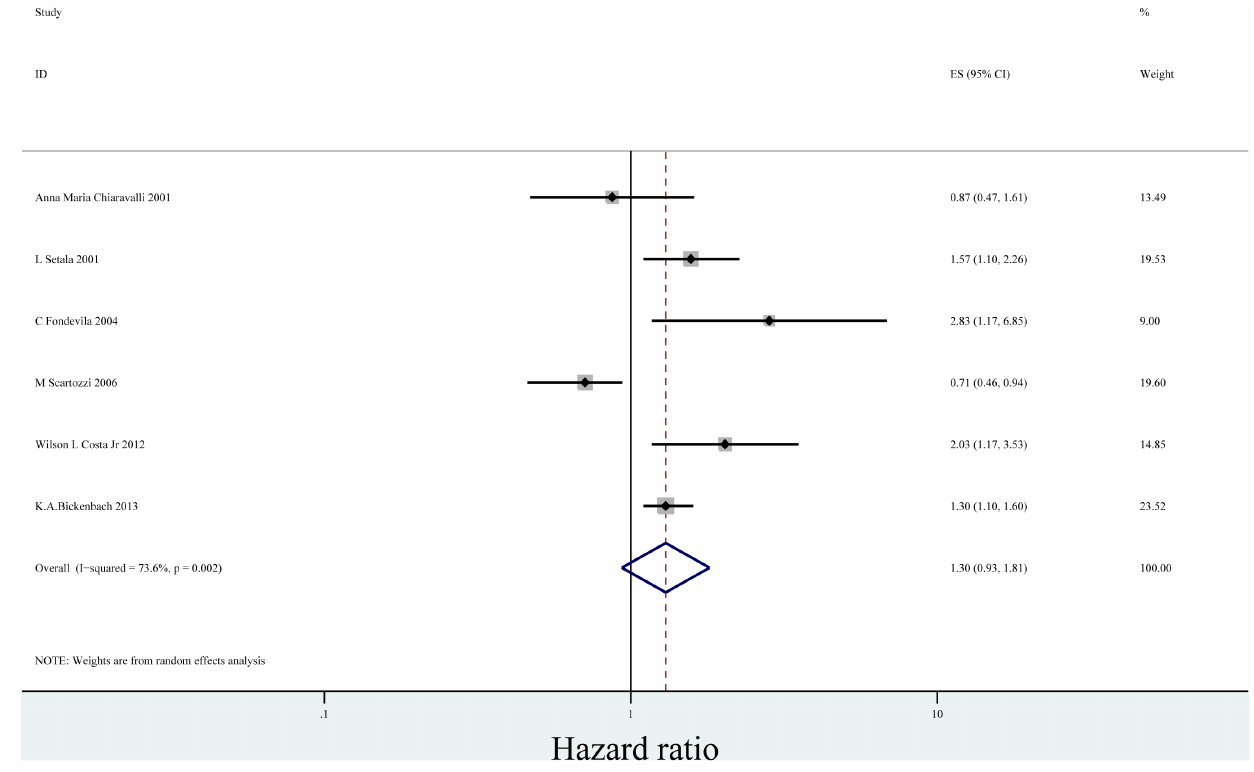
Figure 6. Forrest plot of combined hazard ratio for the association of PNI and OS of non-Asian in multivariate analysis.